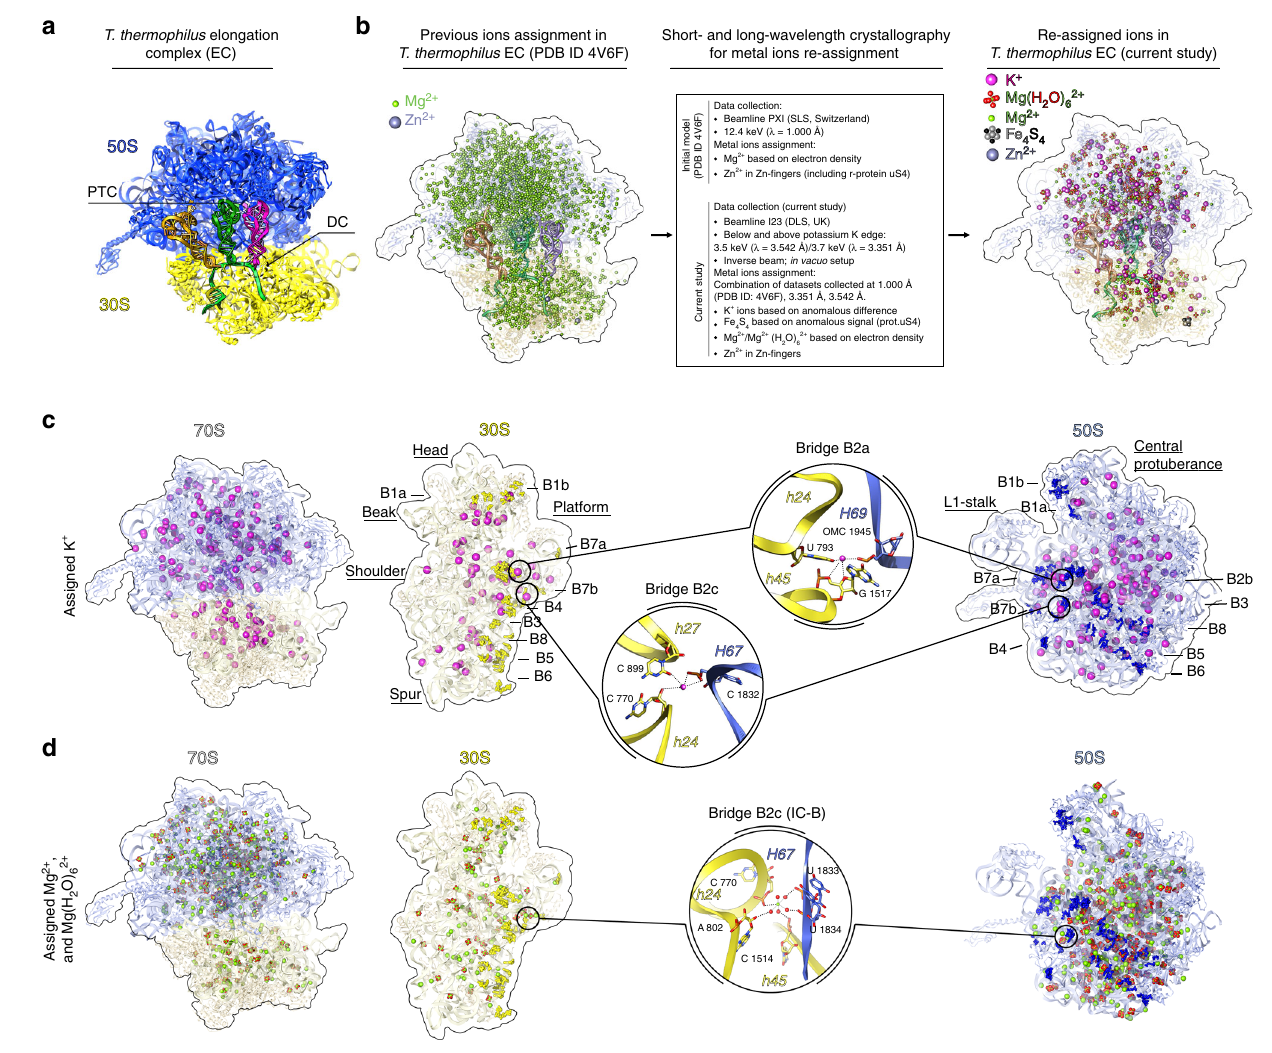
Fig. 1 Metal ions assignment in T. thermophilus 70S ribosome on the example of elongation complex. a Thermus thermophilus 70S EC represents the elongation state of the ribosome that contains poly-U mRNA with SD sequence and three cognate tRNA Phe in the A-, P- and E-sites. Parts of the central protuberance and the 30S head are omitted for clarity. Abbreviations used: PTC peptidyl transferase center, DC decoding center, SD Shine-Dalgarno. b Thermus thermophilus 70S elongation complex (PDB ID 4V6F) was used as an initial model for ions re-assignment. The same complex was crystallized and data were collected at beamline I23 (Diamond Light Source, UK) at two different wavelengths (3.542 and 3.351 Å, which correspond to energies below and above the K-absorption edge of potassium). Electron density from three independent datasets collected at different wavelengths (1.000 Å (PDB ID 4V6F), 3.542 and 3.351 Å) were used to build an atomic model, which contained 211 experimentally distinguished K + ions, 334 Mg 2 + , 251 Mg(H 2 O) 6 2 + , 1 Zn 2 + and 1 Fe 4 S 4 cluster in place of 3255 Mg 2 + and 3 Zn 2 + ions assigned previously. c , d Distribution of K + and Mg 2 + ions within 70S ribosome and each individual subunit. Potassium ions are coordinated in intersubunit bridges B2a and B2c ( c ). One magnesium ion is coordinated in B2c bridge (in the IC magnesium ion has slightly different position and coordinated via water molecules) ( d ). OMC stands for 2 ′ -O-methylcytosine. K + ions colored in magenta, Mg 2 + ions in green, solvent shell shown in red, Zn 2 + in dim gray, in Fe 4 S 4 cluster in iron colored in gray and sulfur in black. Small ribosomal subunit (30S) parts colored in yellow, large subunit (50S) components in blue. Intersubunit bridges are shown in bright yellow and bright blue. For clarity, ions within ribosome are shown in sphere representation with increased van der Waals radius. Additionally, tRNA and mRNA ligands are omitted from the interface